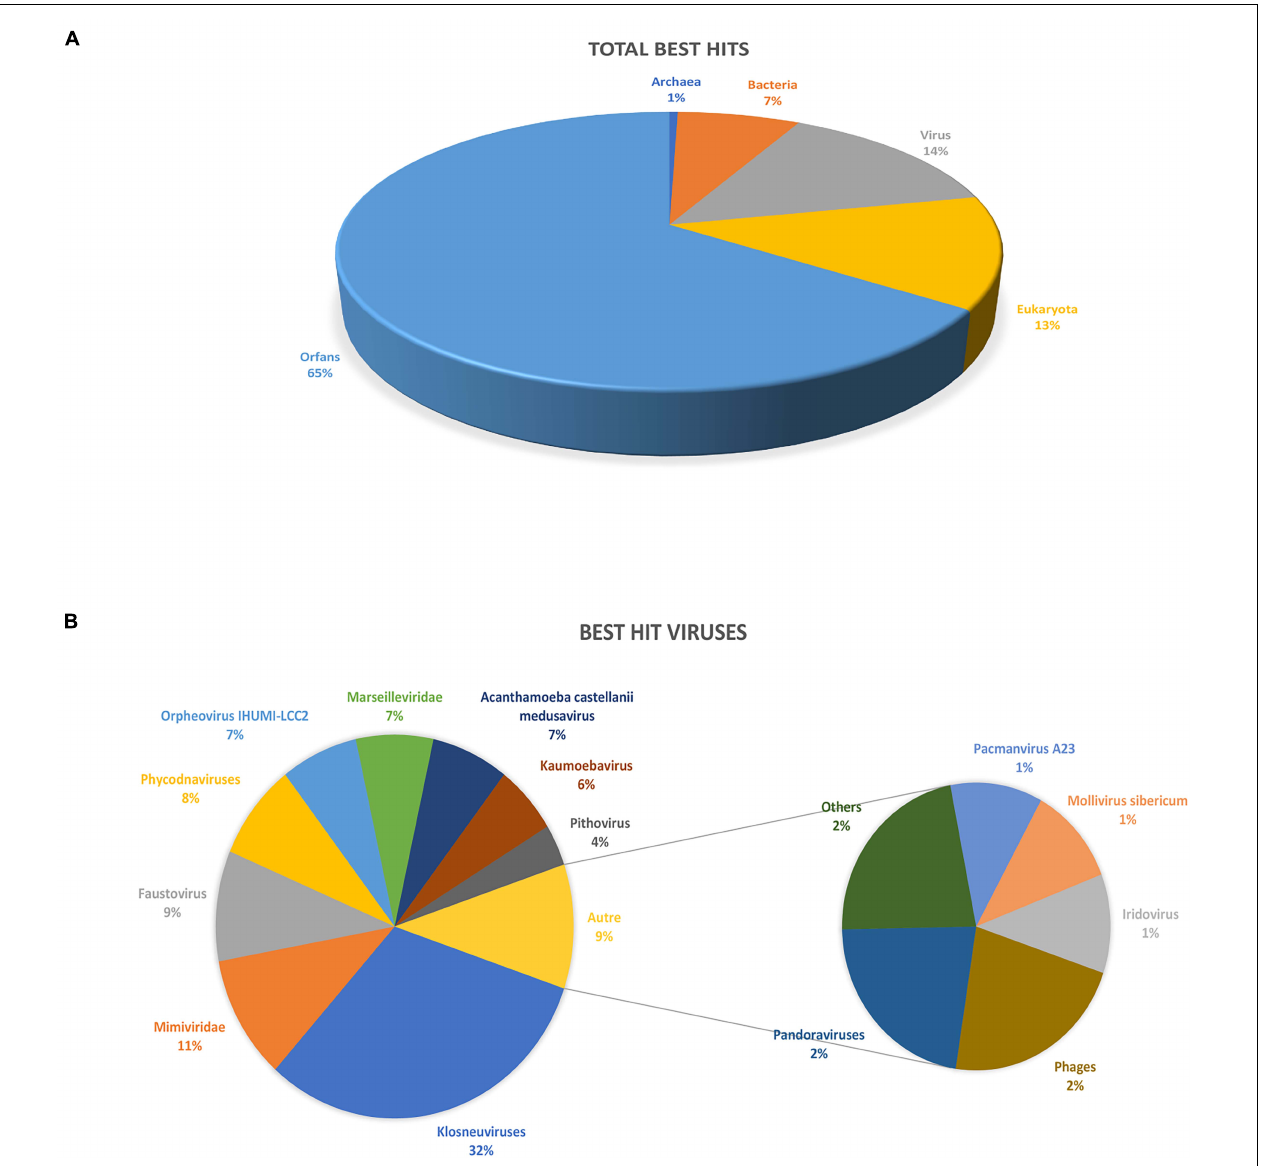
FIGURE 2 | Description of clandestinovirus best hits obtained by blastp against the NCBI non-redundant database. (A) Total number of best hits by blast. (B) Description of the viruses’ best